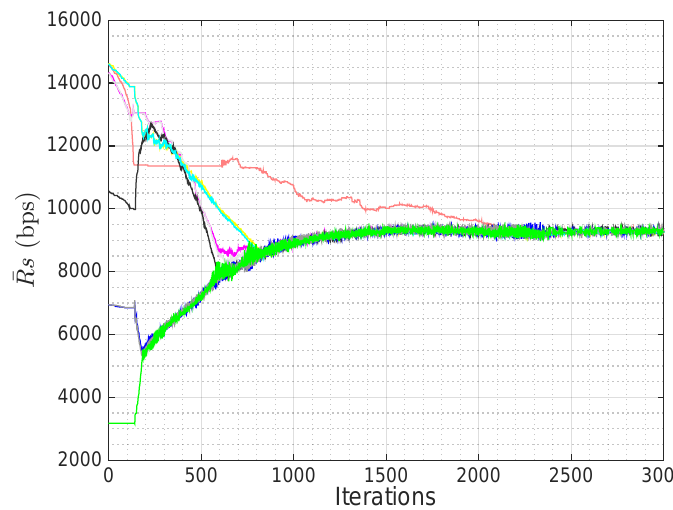
Figure 4. Evolution of the rate per user, for all coverage areas. Each color represents one coverage area using the same colors as the ones assigned to letters in Figure